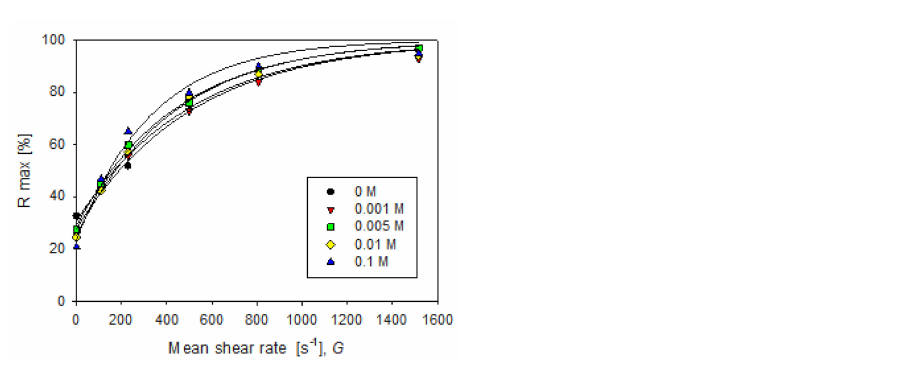
Figure 10. Percentage of maximum rupture (at an infinite time) of aggregates of kaolin in saline solutions (NaCl) for each increase in agitation from the base of G = 273 s − 1